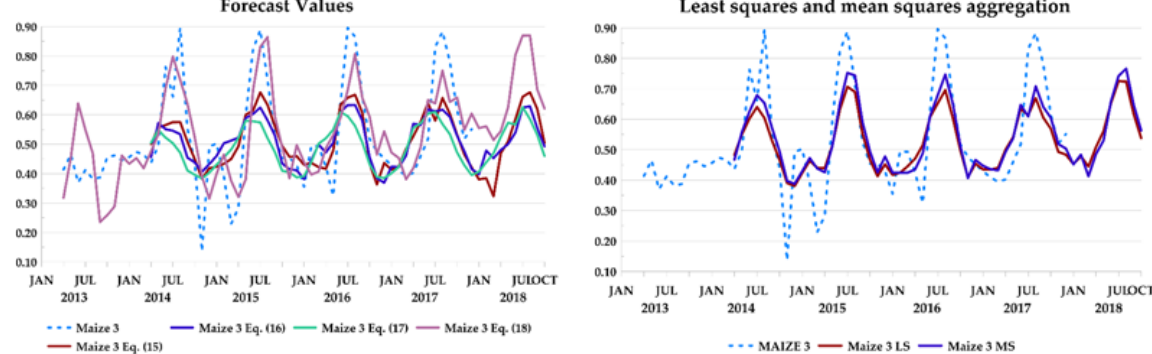
Figure 8. Forecast values for one-year time horizon given by the estimation models presented in Equations (15)–(18) and least squares and mean squares aggregation models.